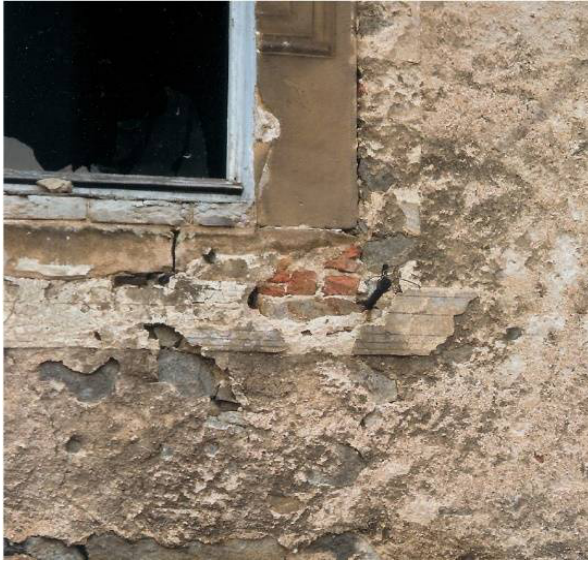
Figure 13. The sgraffito window cornice on the walls of the manor house in Słupice. Photo author, 2003.